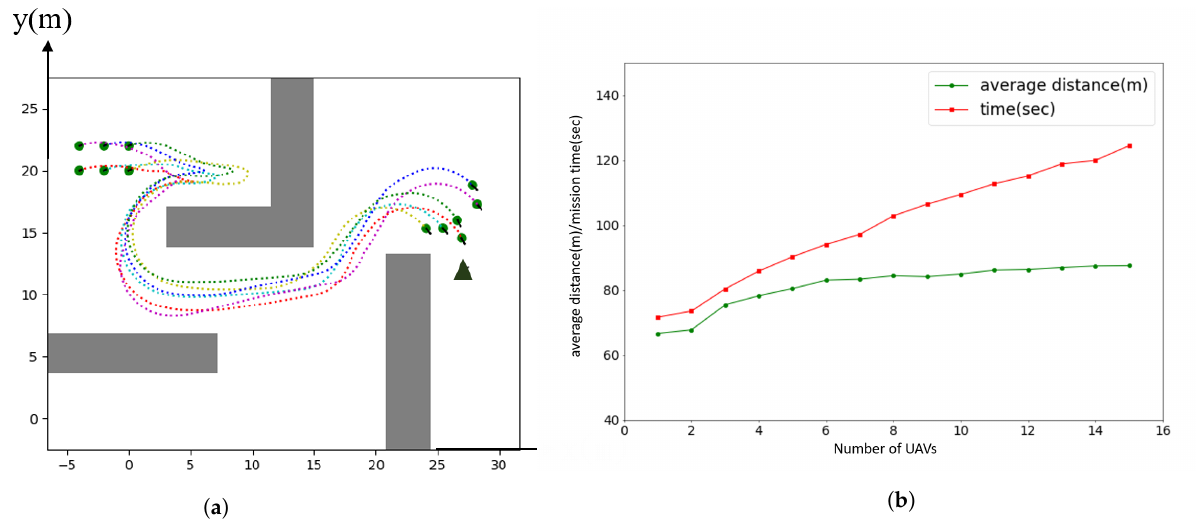
Figure 4. UAVs in Maze-like environment and Analysis: ( a ) All trajectories in a maze-like environment, ( b ) Line chart of the average distance and the total time